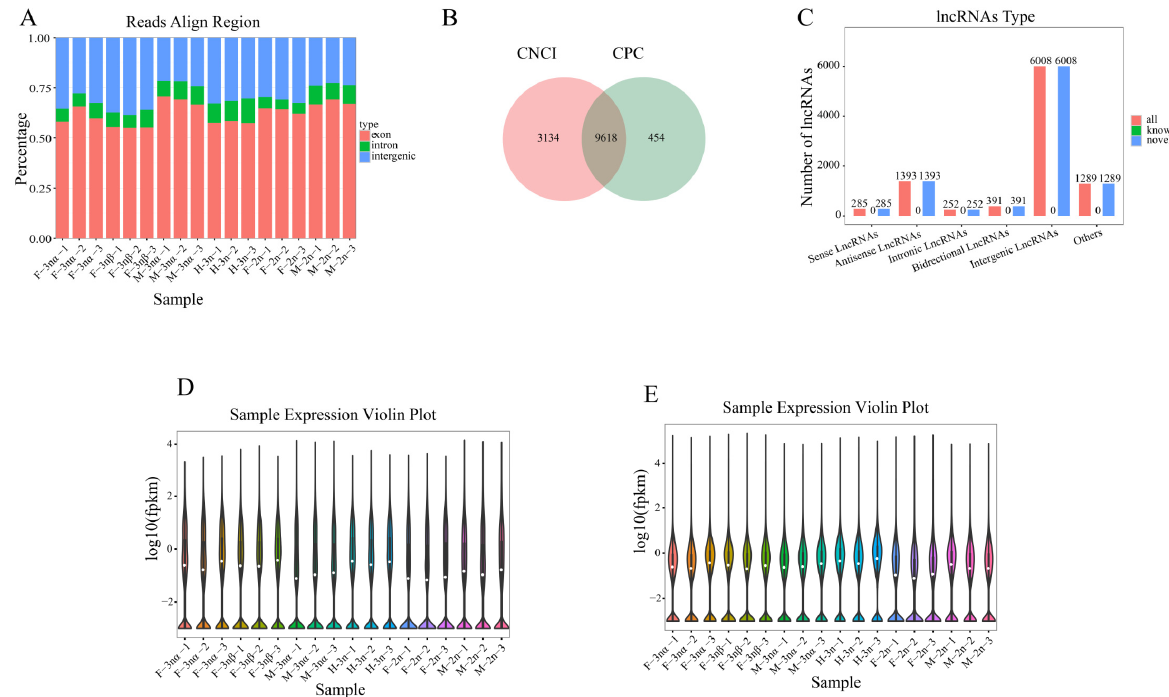
Figure 1. Sequencing and data preprocessing of C. gigas gonad. ( A ) The distribution position in the reference genome of all reads was divided into exon, intron, and intergenic regions. ( B ) The number of reliable lncRNA was predicted with CPC and CNCI software. ( C ) The number of different types of lncRNAs. ( D , E ) Violin diagrams showing expression levels of genes and lncRNAs in each sample.